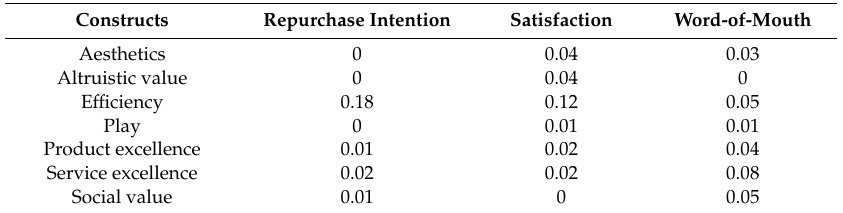
Table 6. f 2 e ff ect sizes.